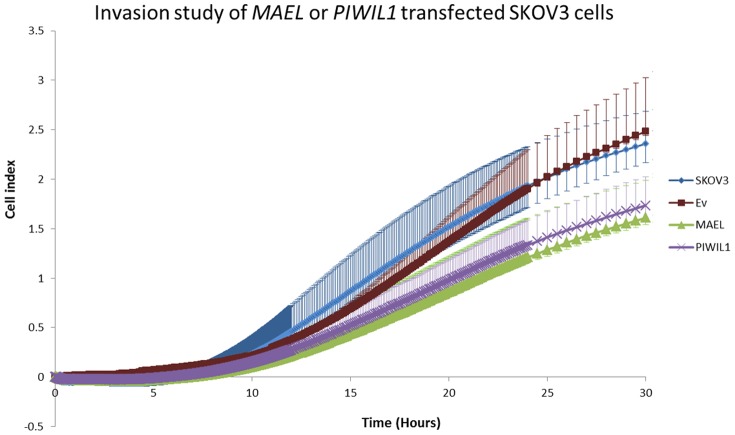
Invasion assay of MAEL or PIWIL1 transfected SKOV3 cells.
PIWIL1 and MAEL transfected cells have lower invasiveness compared to untransfected cells and Ev transfected cells. In each experiment, each group was performed in triplicate and this experiment was repeated three times. This is a combined data plot of three independent experiments for all groups. Error bars represent standard deviation. WT indicates untransfected SKOV3 cells; empty vector (Ev), MAEL and PIWIL1 indicate cells transfected with MAEL or PIWIL1 vectors. None indicates well without cells.